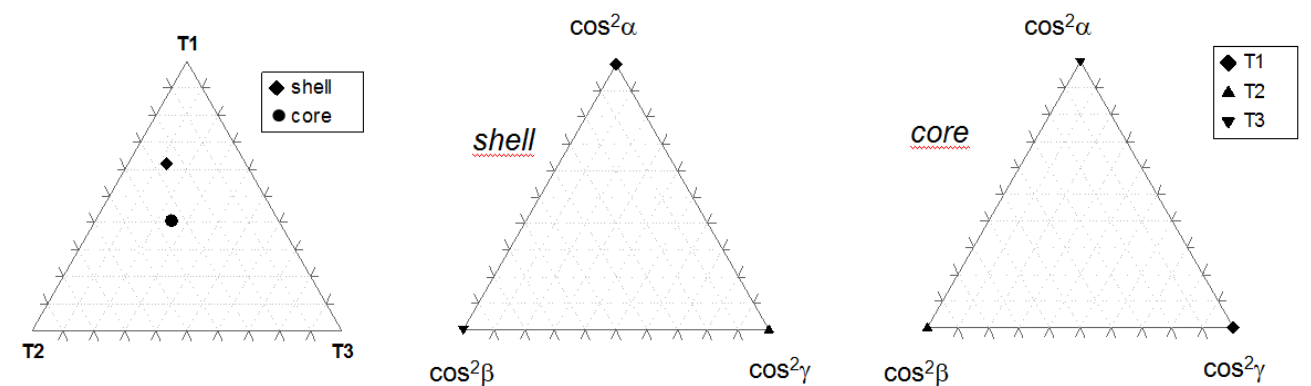
Figura 15: Rappresentazione su grafico ternario dei parametri del fabric tensor nelle zone shell e core .